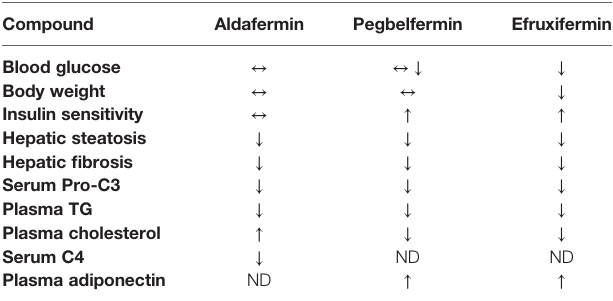
TABLE 2 | Summary of observations in clinical trials of FGF19 and FGF21